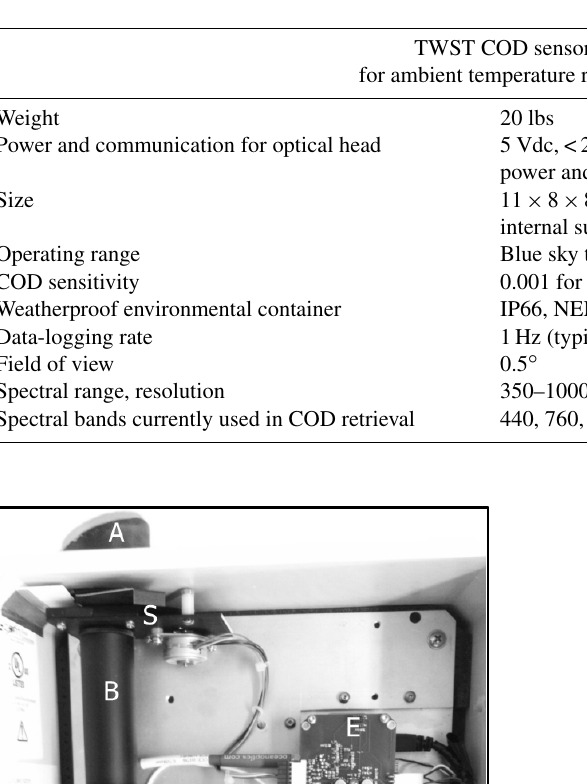
Table 1. TWST cloud optical depth sensor specifications.